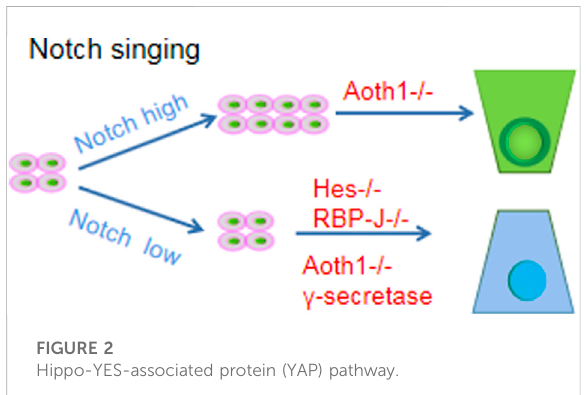
FIGURE 2 Hippo-YES-associated protein (YAP)